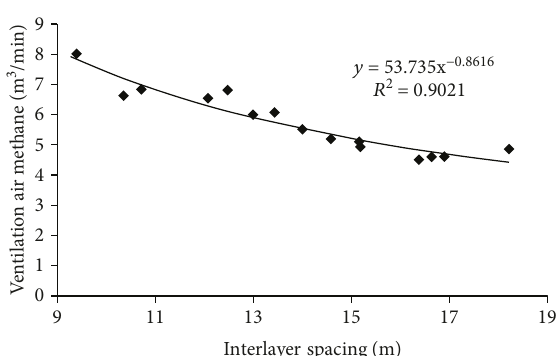
y = 53.735x −0.8616 R 2 = 0.9021